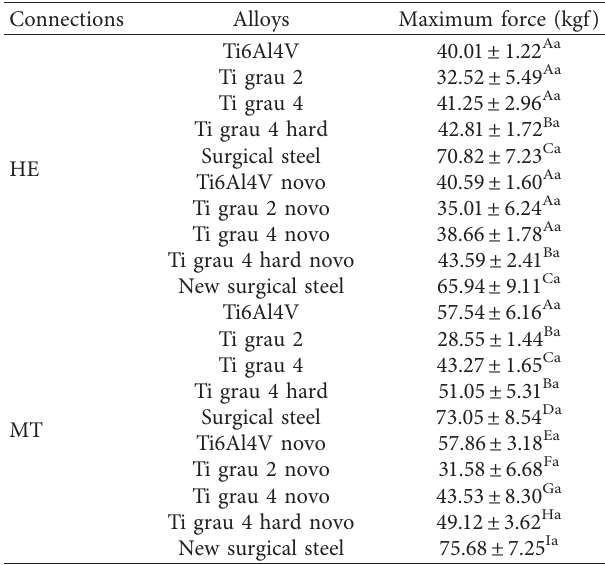
Figure 8: Graphical representation of the averages and standard deviation of the connections in relation to the analyzed untorque periods. Table 4: Means and standard deviations for maximum force (kgf) as a function of alloy type for HE and MT fittings.